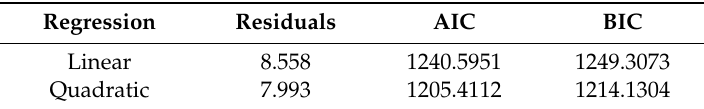
Figure 6. Regression models. Table 9. Fitting parameters. Regression — Table 10. Residuals, Akaike’s information criterion (AIC) and Bayesian information criterion (BIC) values.